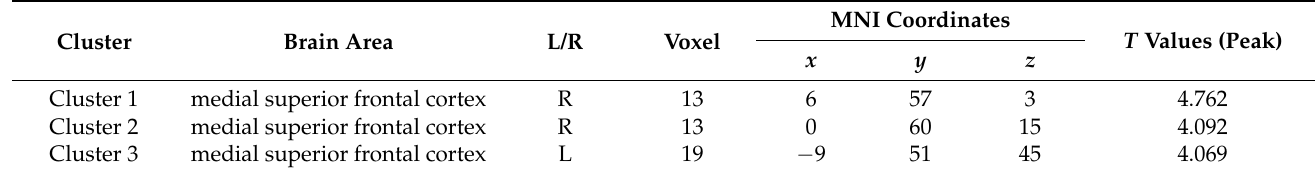
Table 2. Differences in the right SPL-DMN FC between the AP group and the OP